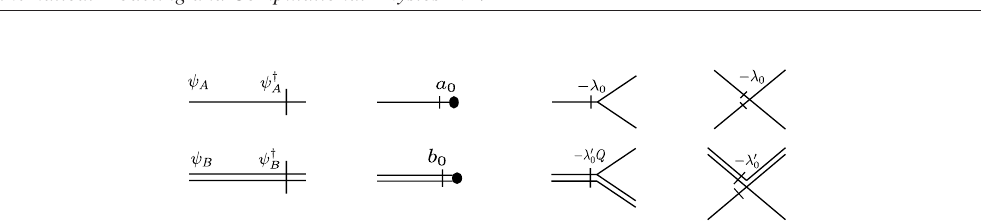
Figure 1. Propagators, initial conditions and vertices of the theory described by the action